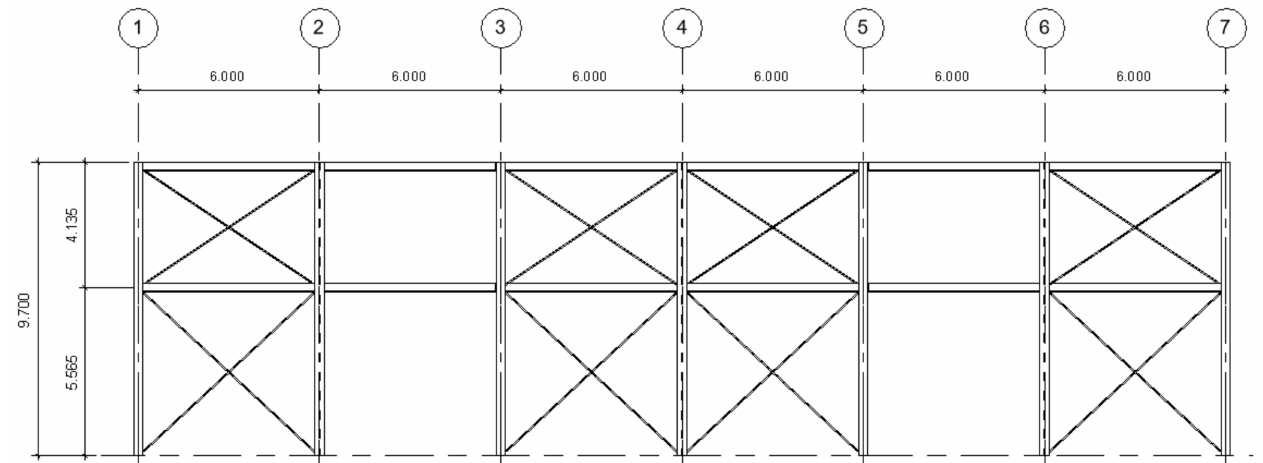
Figure 2. Elevation view of the warehouse (dimensions in m).